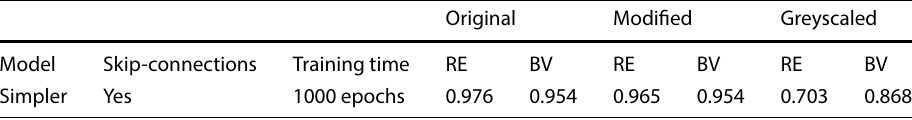
RE the reconstruction error approach, BV the bottleneck-values